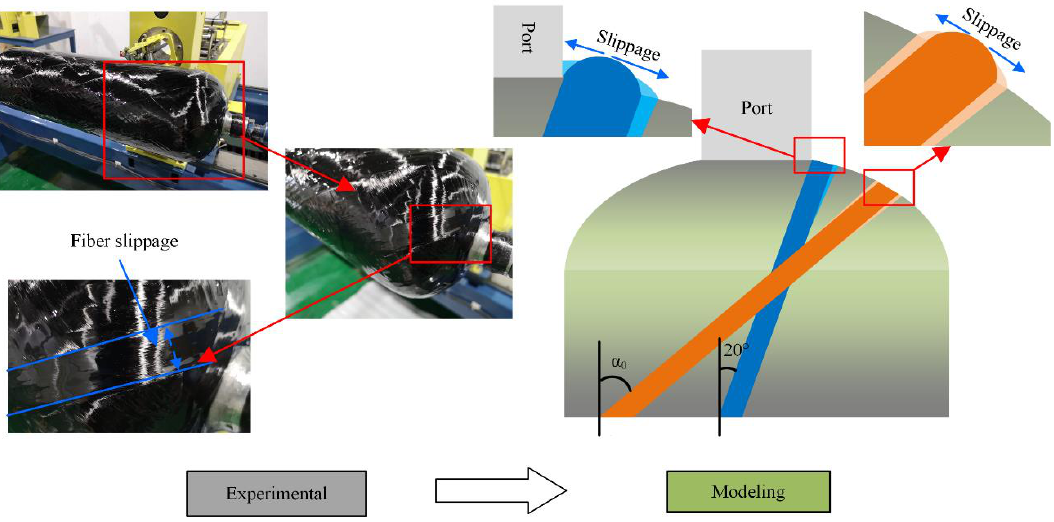
Figure 1. Schematic diagram of fiber slippage at different winding angles.